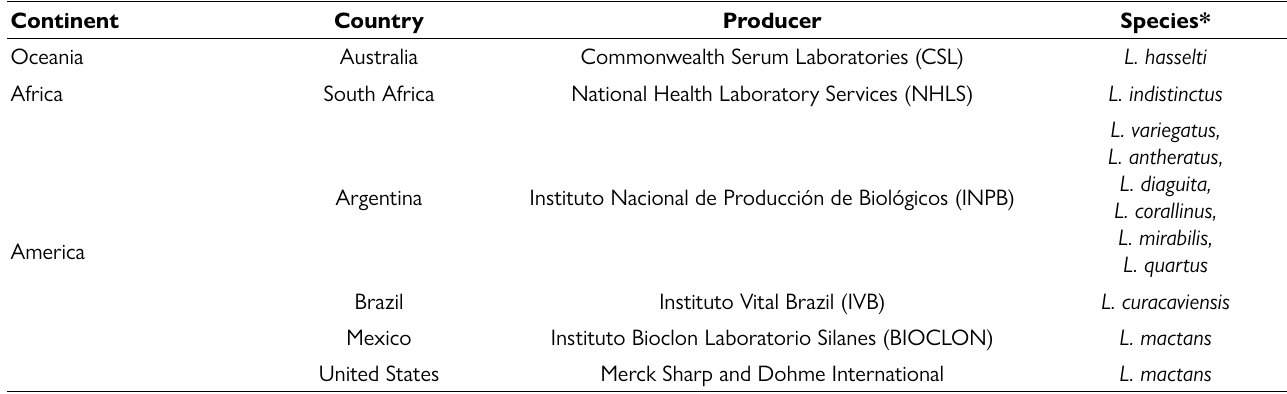
Table 1. List of the anti- Latrodectus antivenoms produced in the world. Continent Country